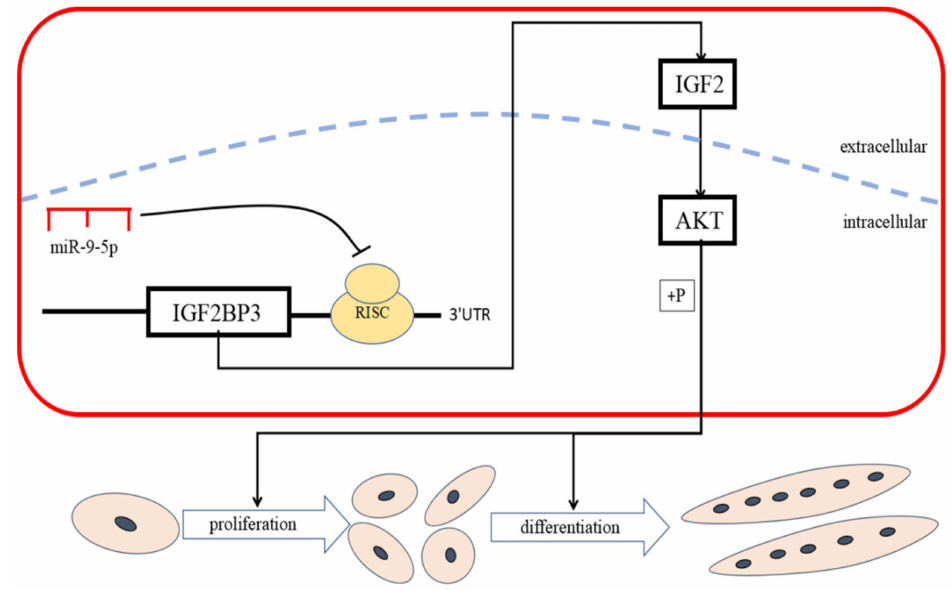
Figure 8. miR-9-5p inhibits skeletal muscle cell proliferation and di ff erentiation by targeting IGF2BP3 through the IGF2-PI3K / Akt signaling